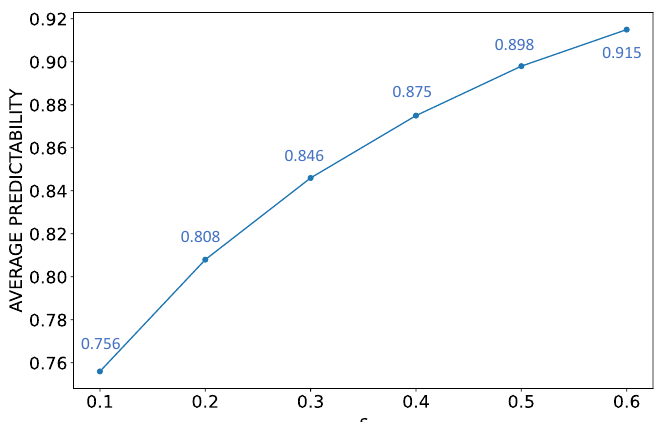
Figure 12. The relationship between the average SST predictability in the global sea region and the value of (cid:101)